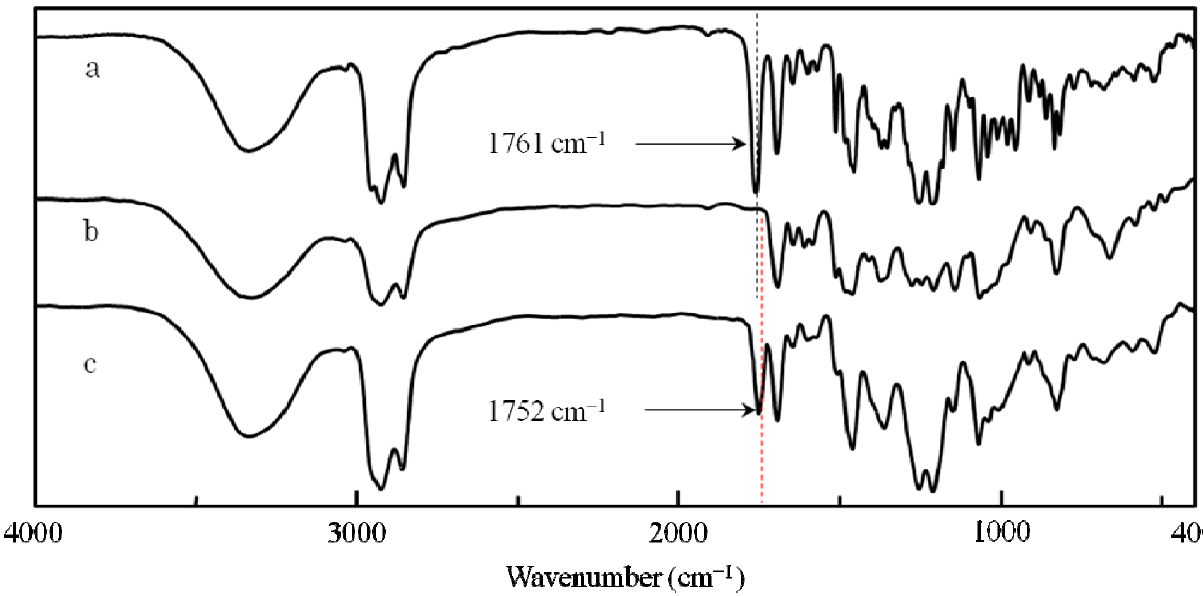
Figure 5. IR spectra of (a) poly( 1 ), (b) poly( de -1 ) and (c) poly( re -1 ) (film).